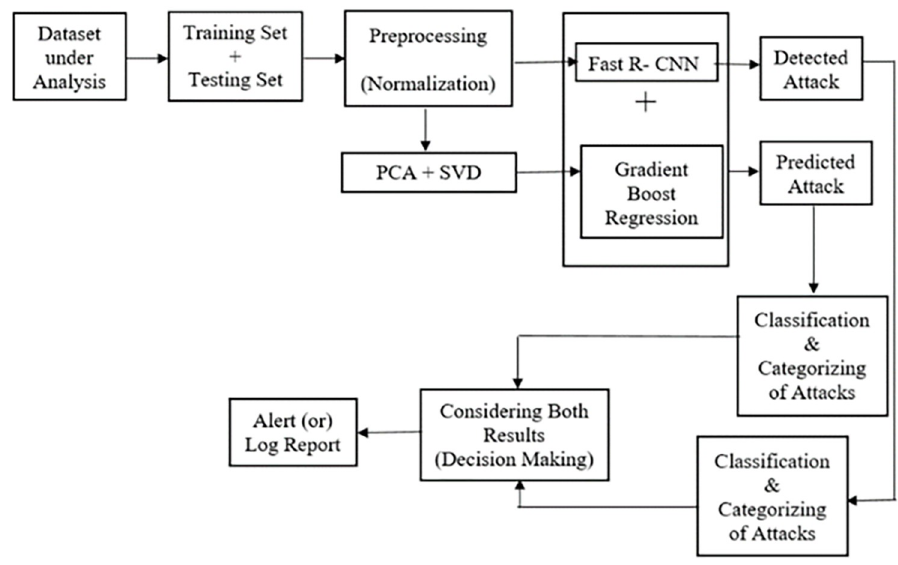
Fig 3. Feature extraction of proposed